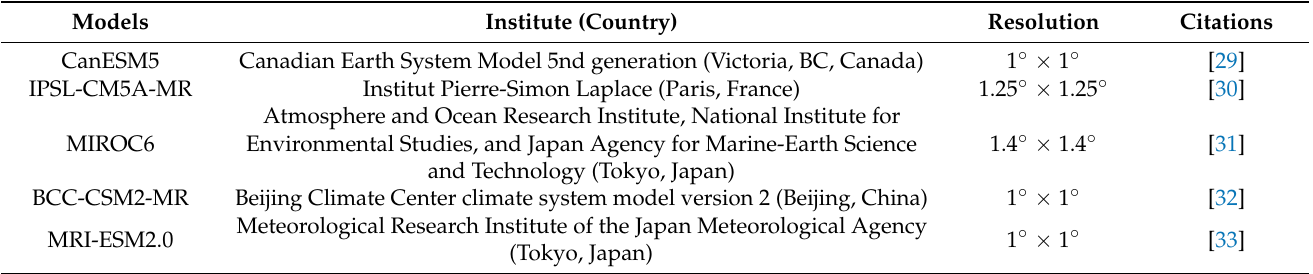
Table 1. CMIP6 (Intercomparison Model Projects) models: the 5 General Circulation Models (GCMs) used in this study.